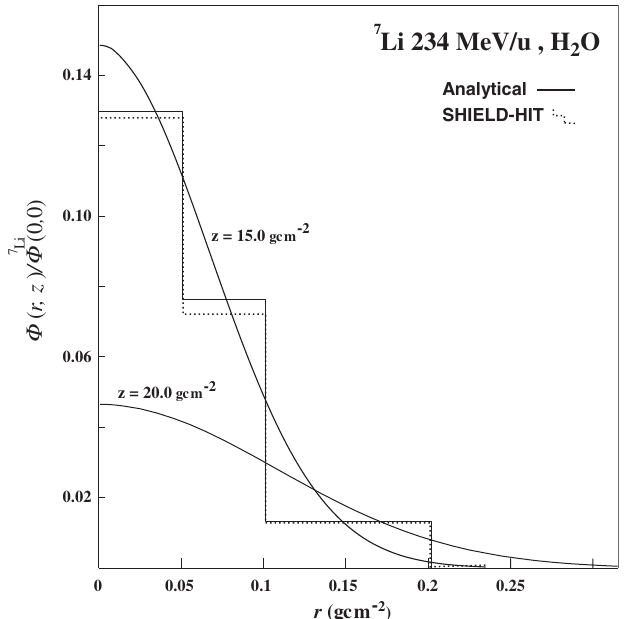
FIG. 4. The spatial analytical radial fluence distribution [Eq. (26)] at different depths (solid lines) of primary 7 Li in a 234 MeV = u 7 Li beam in water compared with MC (dotted lines histograms). The results have been normalized to the primary particle values at the phantom surface. The advantages of the continuous analytical expressions developed in this paper are clearly seen here in relation to the segmental MC data.